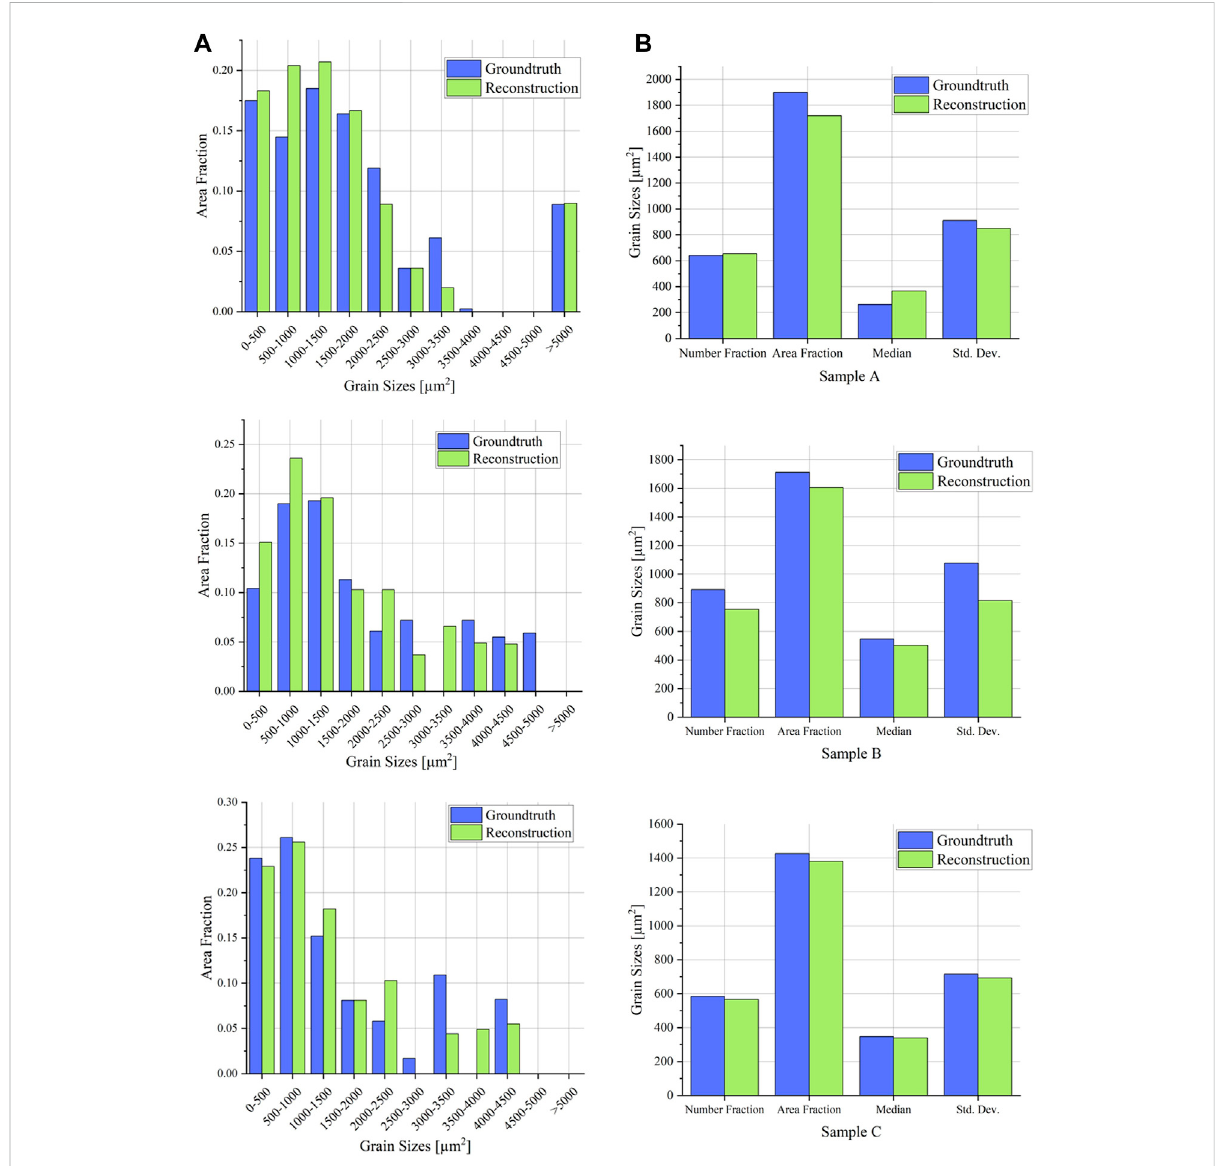
FIGURE 7 Comparison of the segmentation results to corresponding ground truths of the three validation samples. (A) : grain size distribution, (B) : characteristic grain size parameters. The deviation between the grain sizes between reconstruction and groundtruth is only small. Sample C containing a higher amount of bainitic microconstituents shows the least difference. The area fraction mean grain size of the martensitic sample A contains the highest error, underestimating the grain sizes. With decreasing cooling rates that error becomes less